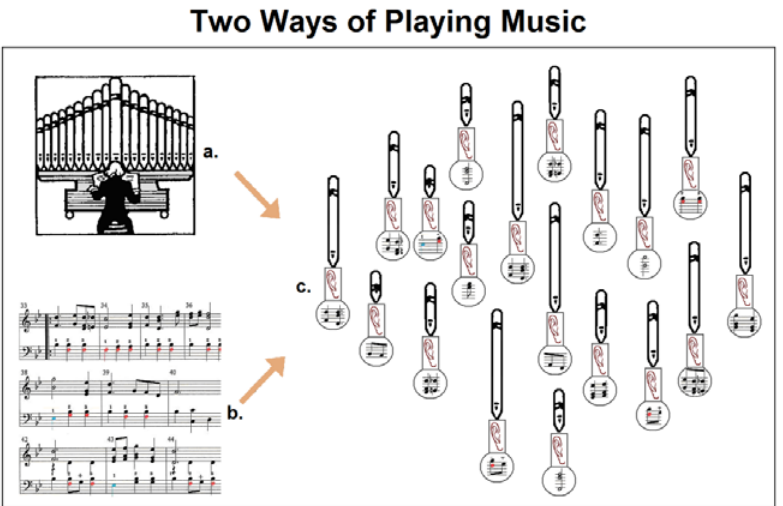
Figure 9. Two Ways of Playing